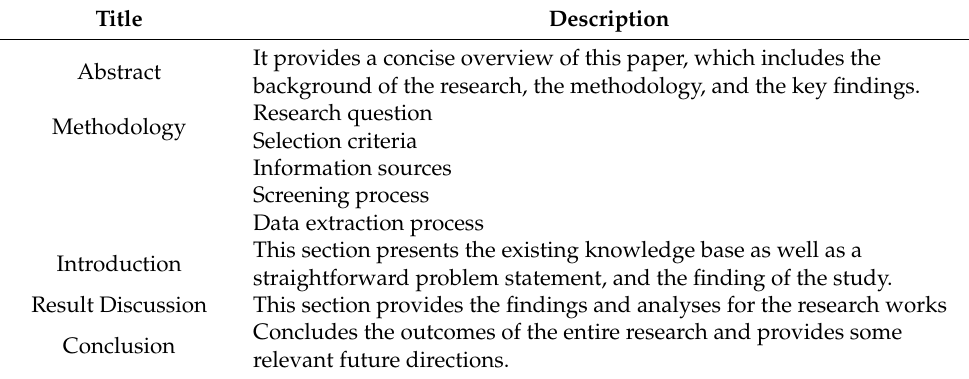
Table 2. Method for this SLR based on PRISMA protocol.